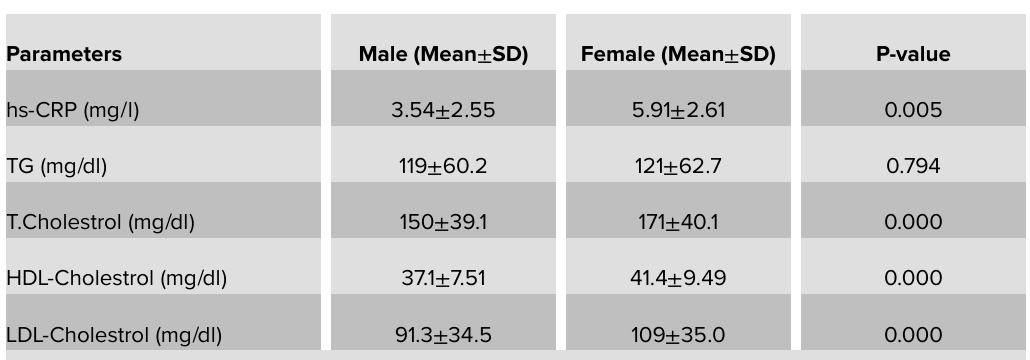
Table 3: Compersion of study parameters in patients groups classified according to gender.